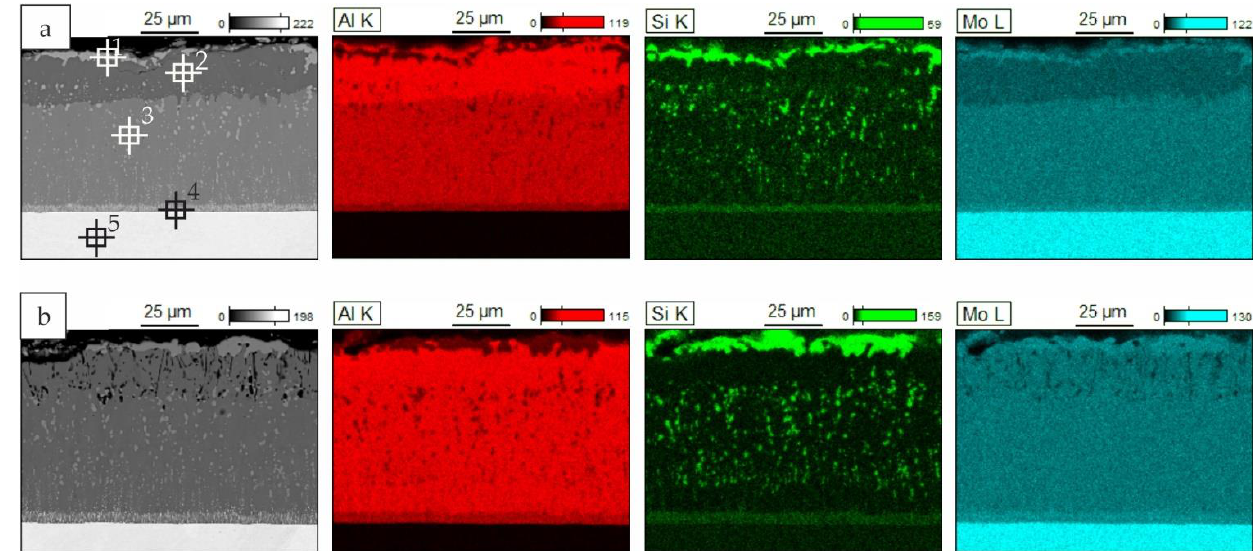
Figure 8. Elemental mapping (BEI/EDS) of cross – sections of Si-Al coatings obtained on TZM alloy at 1000 °C with the slurry volume of 0.15 g/cm 2 for ( a ) 2; ( b ) 4 h (with points of X-ray microanalysis). Table 3. The results of the EDS point analysis of Si-Al coating according to Figure 8a. Point of Analysis Chemical Composition, %